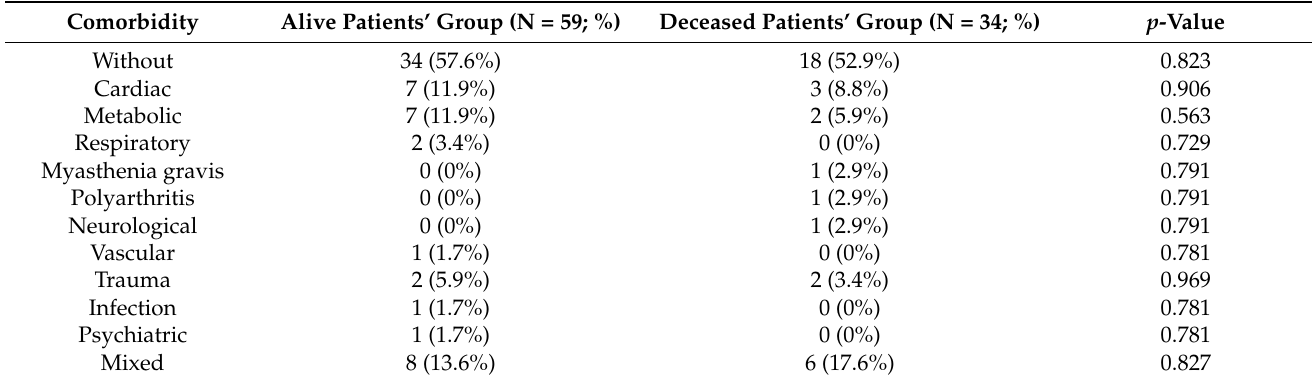
Table 3. Comparative analysis of laboratory parameters between the studied